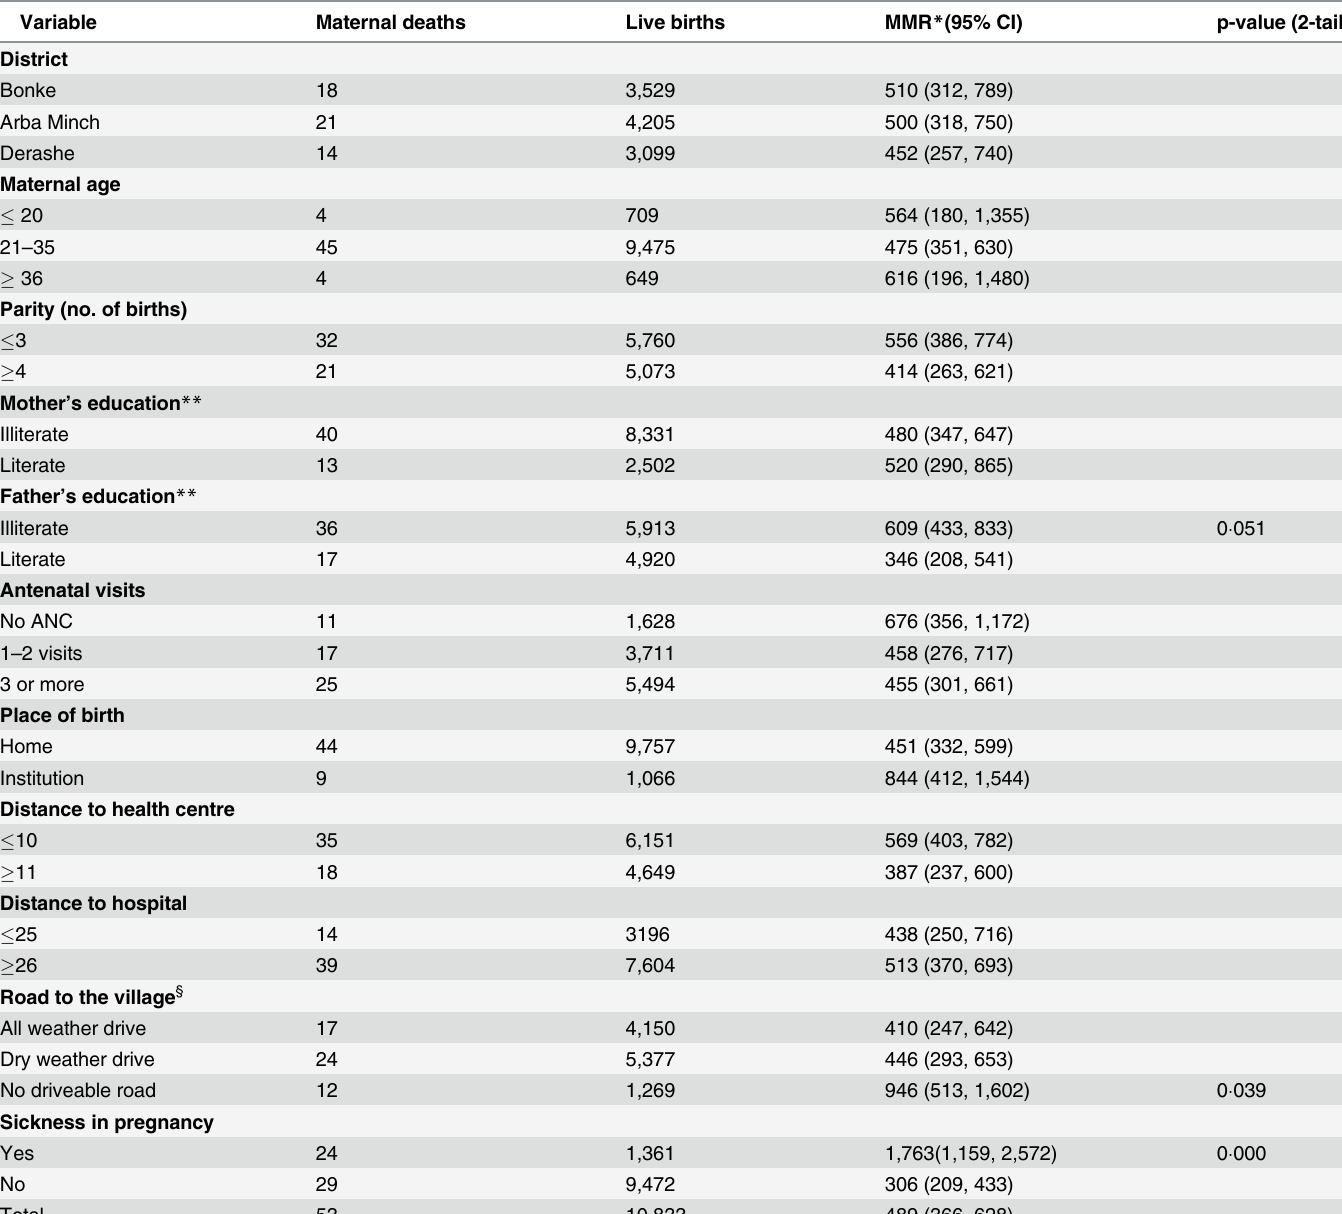
Table 3. Variations in maternal mortality across variables, south Ethiopia,